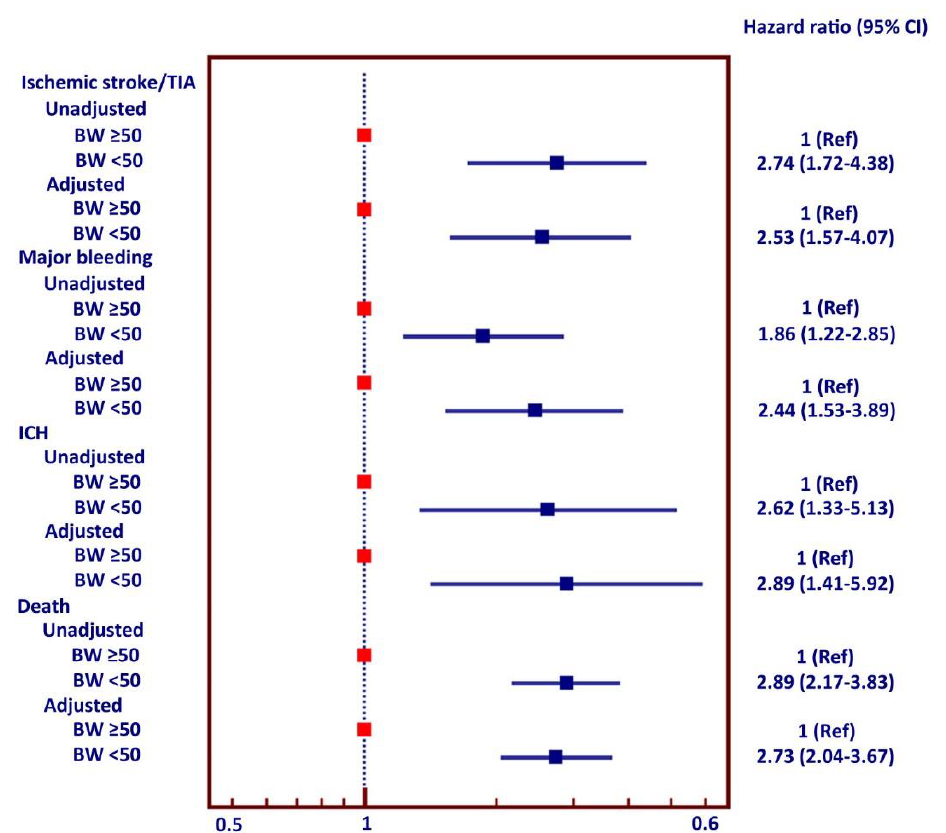
Figure 3. Forest plot shows unadjusted and adjusted hazard ratio of ischemic stroke / transient ischemic attack (TIA), major bleeding, intracerebral hemorrhage (ICH), and death in patients with low bodyweight and non-low body weight. The Cox proportional hazards model was used for analysis.